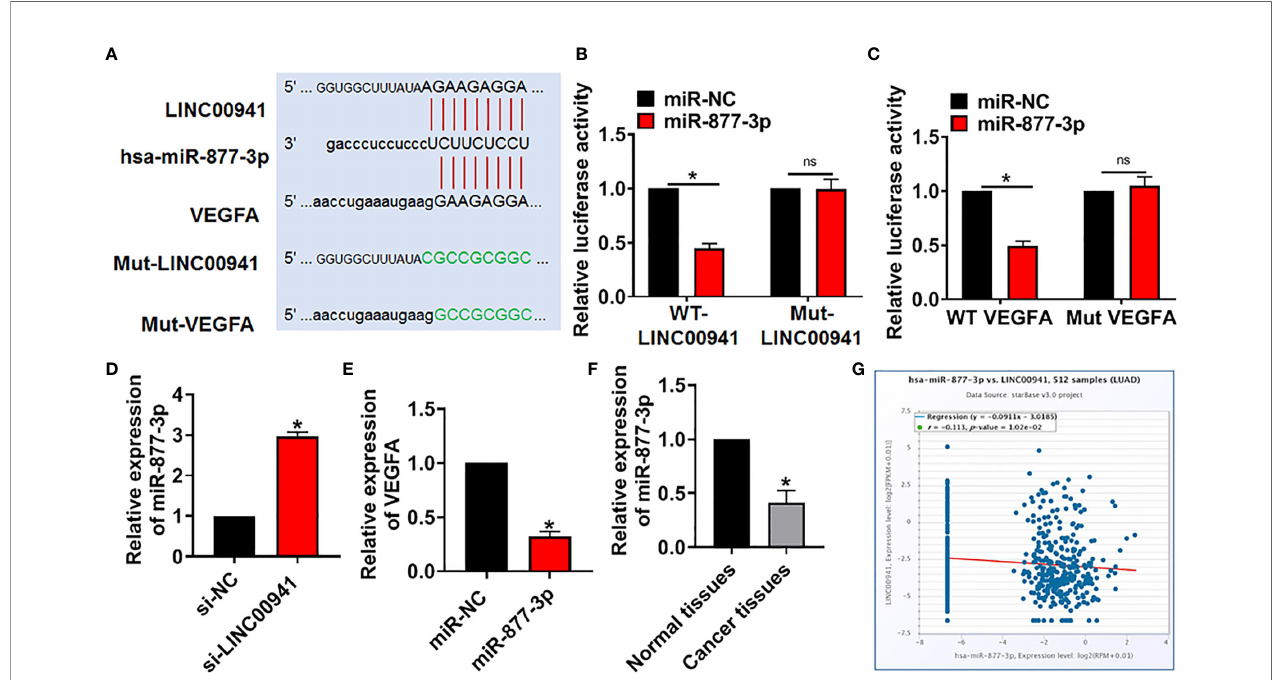
FIGURE 4 | LINC00941 acted as a competitive endogenous RNA for miR-877-3p and modulated VEGFA level. (A) Bioinformatics used to predict the binding bases of miR-877-3p and LINC00941/VEGFA. (B) Wild type and mutant LINC00941 was transfected into HEK293 cells with or without miR-877-3p, and luciferase assay was to evaluate the binding between miR-877-3p and LINC00941. (C) Luciferase assay was to test the binding between miR-877-3p and VEGFA. (D) A549 cells were transfected with si-LINC00941/si-NC, the expression of miR-877-3p was tested. (E) The expression of VEGFA was determined after miR-877-3p mimic transfection in A549 cells. (F) The level of miR-877-3p in normal and cancerous tissues of NSCLC patients was detected. (G) ENCORI website used to determine the correlation between LINC00941 and miR-877-3p in lung Adenocarcinoma (LUAD). Data are mean ± SD; *P < 0.05, ns, no statistical signi fi cance. All experiments were repeated three